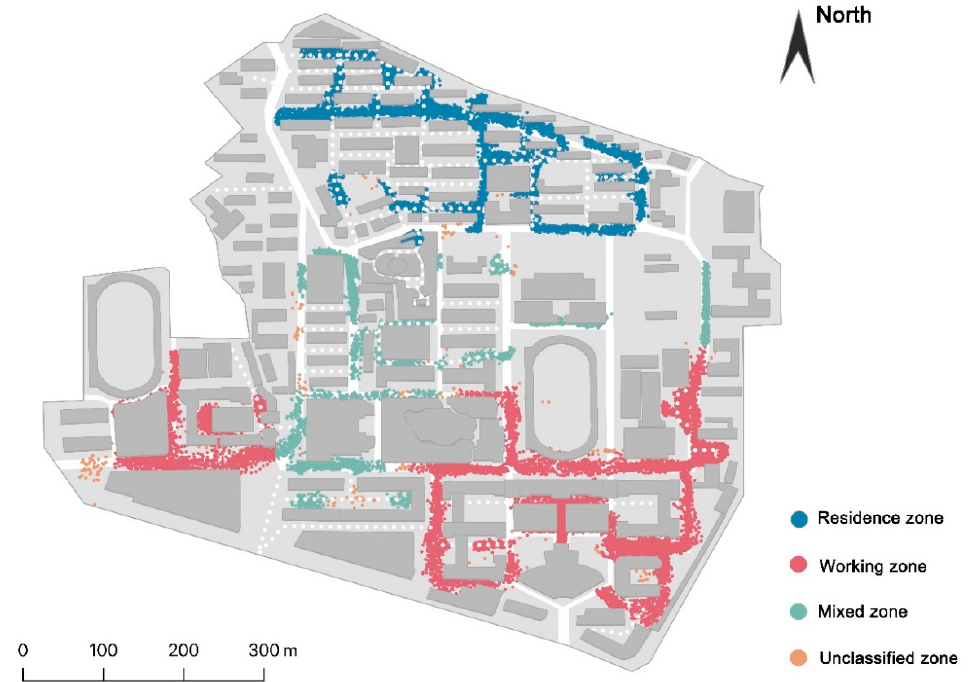
Figure 6. The distribution of four parking zones in the Information Department campus of Wuhan University. The source of the map is OpenStreetMap.